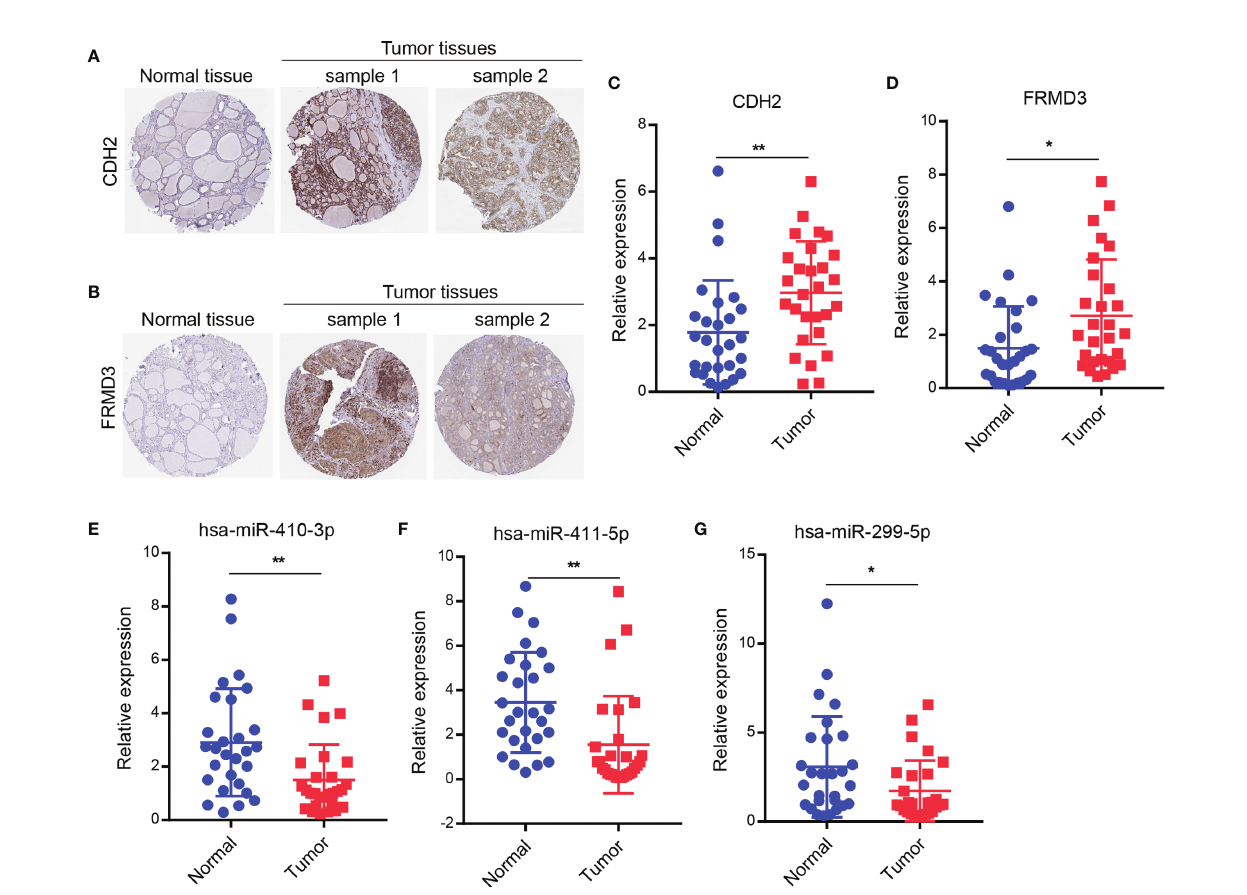
FIGURE 5 | Identi fi cation of genes and miRNAs expression in clinical THCA tissues. (A, B) The protein expression of CDH2 or FRMD3 by IHC using the HPA database. (C, D) The mRNA levels of CDH2 or FRMD3 were checked in 28 paired clinically fresh THCA of carcinoma and paraneoplastic tissues by qRT-PCR assay. (E – G) The miRNA levels of has-miR-410-3p or has-miR-411-5p or has-miR-299-5p were measured in 28 paired clinically fresh THCA of carcinoma and paraneoplastic tissues by qRT-PCR assay. *P < 0.05; **P <